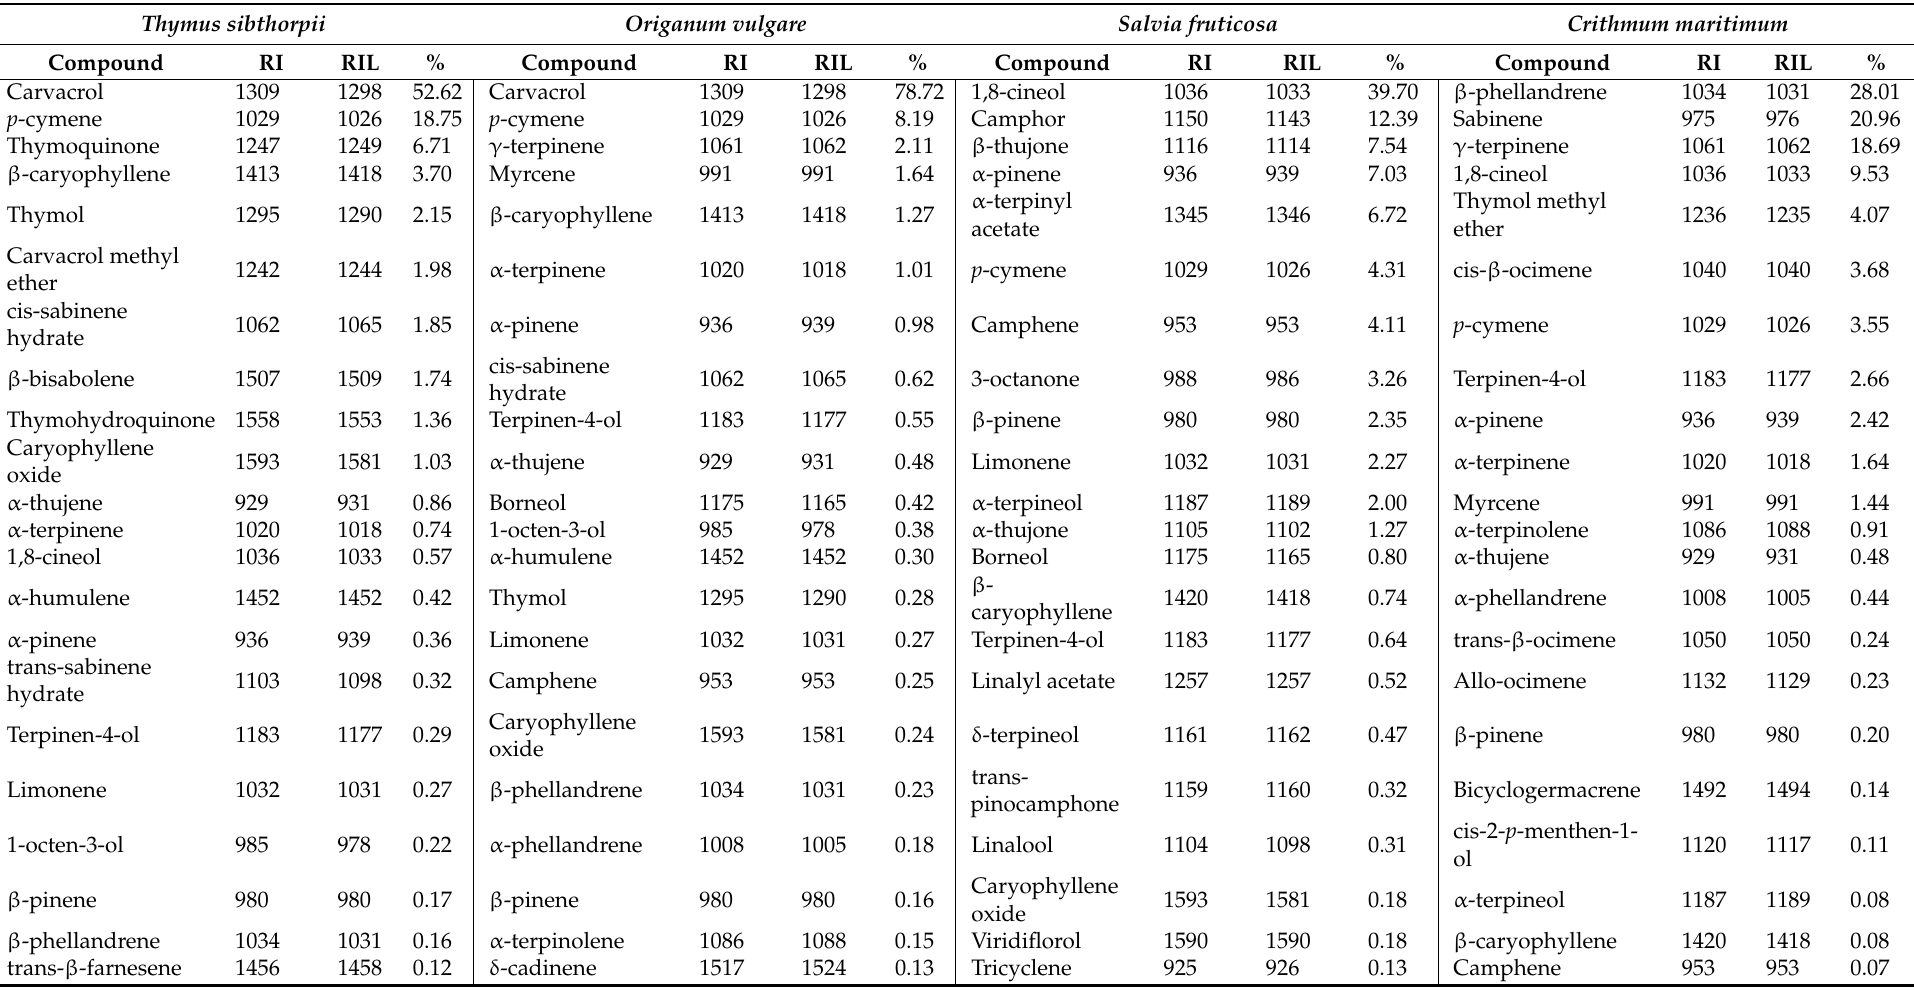
Table 1. The essential oil composition of Thymus sibthorpii , Origanum vulgare , Salvia fruticosa , and Crithmum maritimum isolated during the flowering period, including the percentage of components and the experimental (RI) and literature-based (RIL) retention